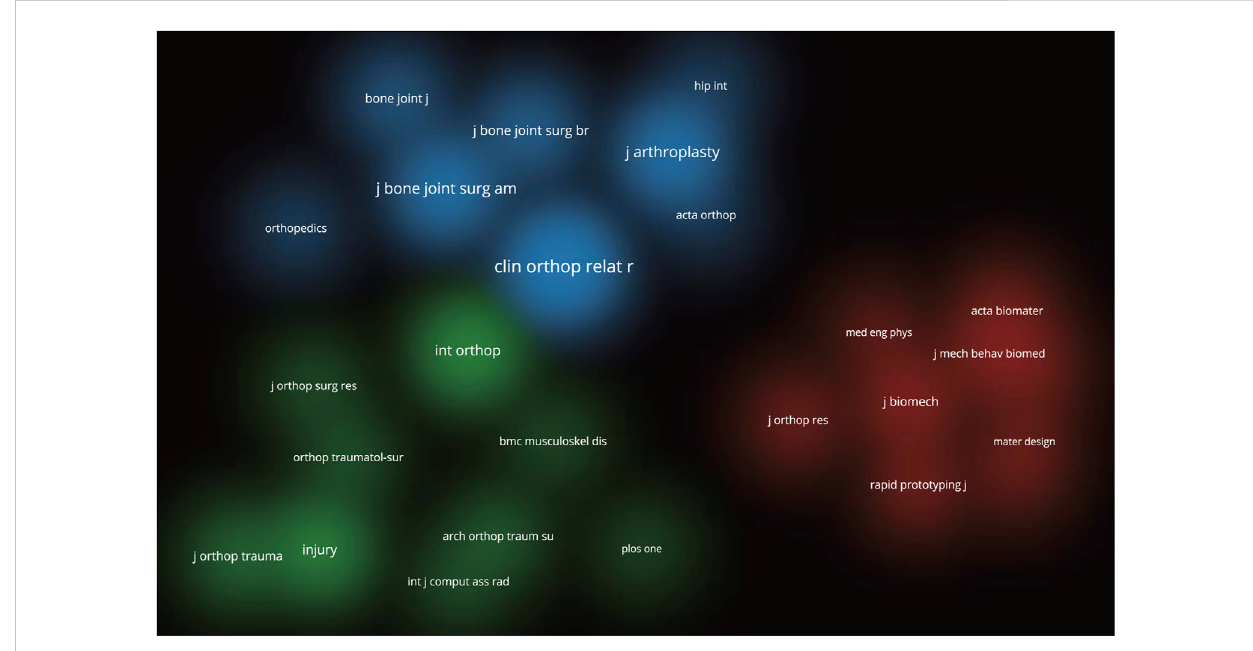
FIGURE 4 Density visualization of the co-cited journals. (A wider range of circles indicates that the journal has been cited more frequently. Different colors represent different clusters, so the co-cited journals can be seen to be divided into three clusters.).